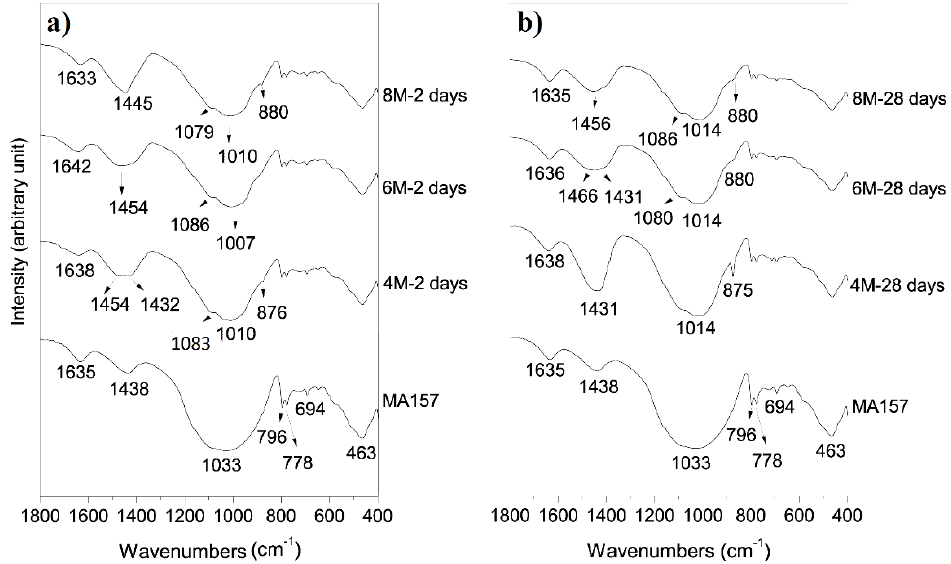
Figure 4. FTIR spectra for anhydrous MA157 clay and ( a ) two days and ( b ) 28 days pastes alkali- Figure4. FTIRspectraforanhydrousMA157clayand( a )twodaysand( b )28dayspastesalkali-activated activated with 4, 6 and 8 M NaOH. with 4, 6 and 8 M